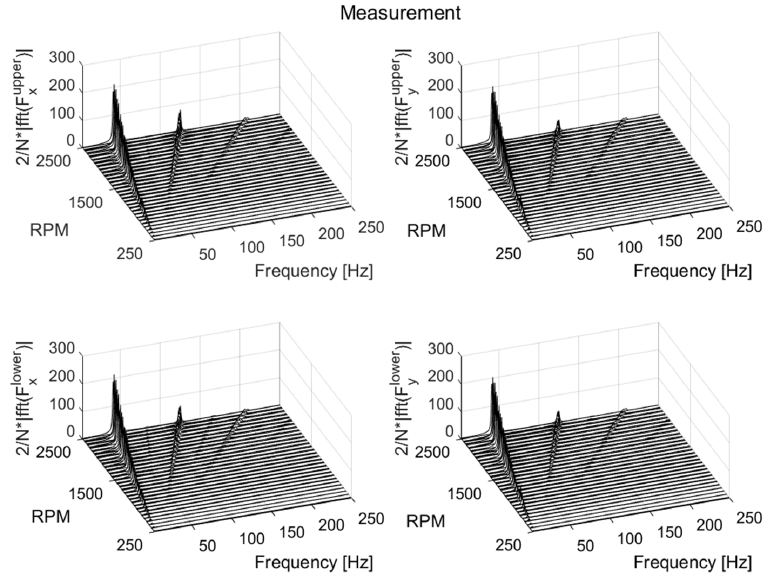
Figure 26. The waterfall diagram of the measured bearing forces with 5.9 × 10 − 3 kg·m and 2 π rad/s 2 . N is the number of samples.